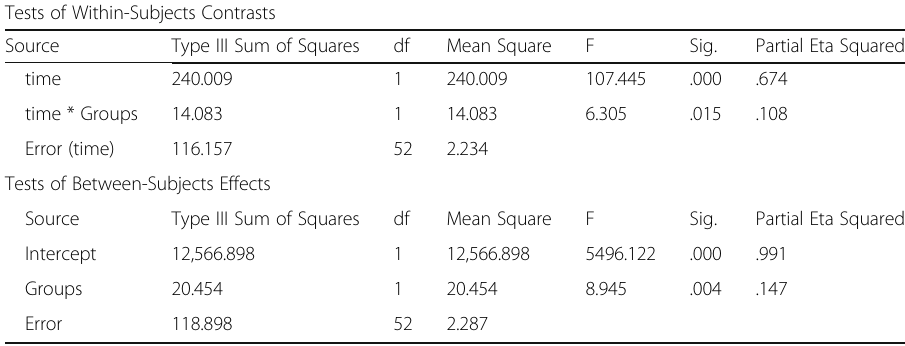
Table 5 Results of mixed-ANOVA on reading comprehension pretest and posttest with time and group factors